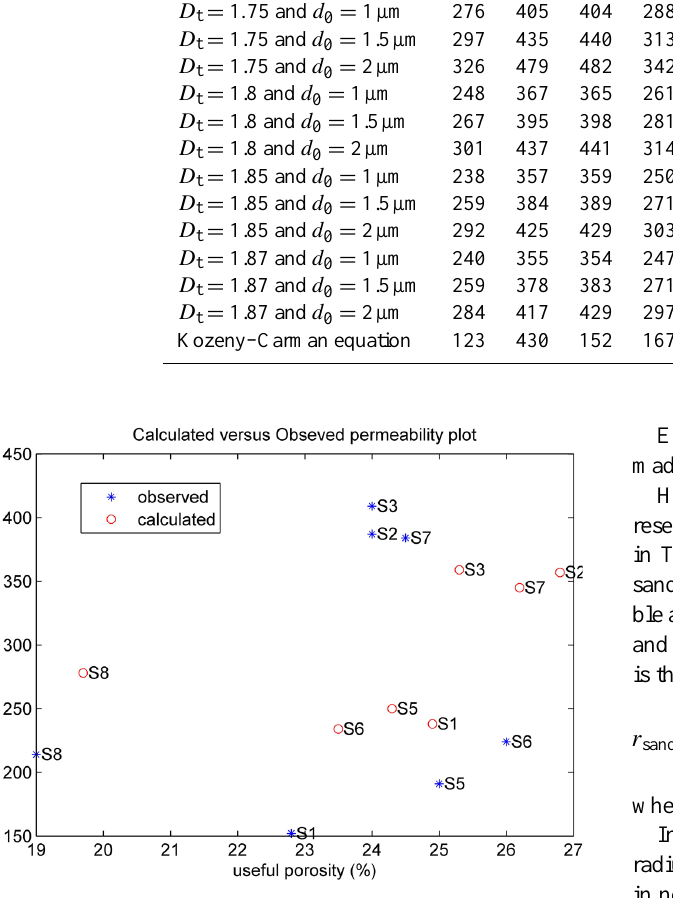
Fig. 4. Permeability versus porosity plot for well (W1). Calcu- lated average reservoir permeability (circles) falls in the range of observed average reservoir permeability values (stars). Sand layer names (S1 to S8) annotated to the data points clearly show the amount of deviation from predicted permeability with respect to the corresponding observed